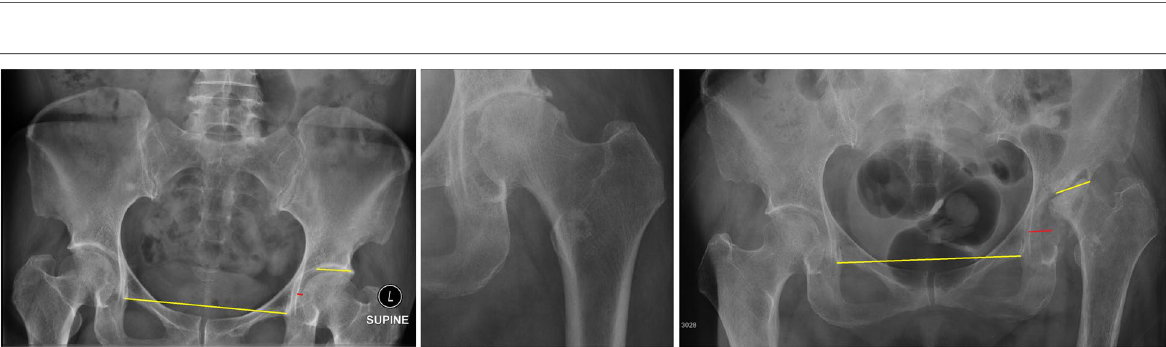
Fig. 1 Left (normal), measuring the pelvic tilt diameter, Wiberg angle, and head diameter. Middle (type 1 RPOA, loss of joint space), measuring the superior joint space. Right (type 2 RPOA, superior acetabulum and femoral head destruction), measuring the superior acetabular bone loss and final leg length discrepancy